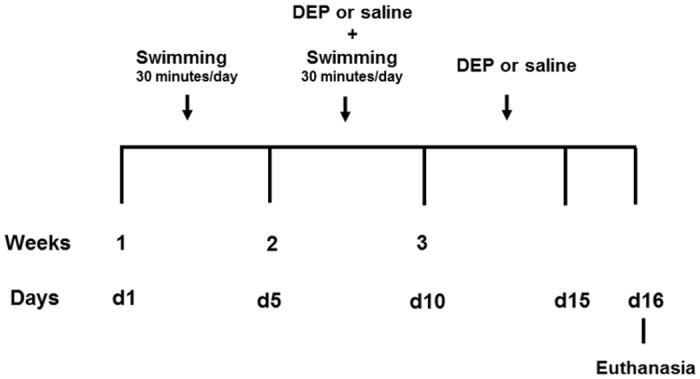
Time line of the experimental protocol.Swimming was initiated on day 1, and ended on the 10th experiment day. DEP instillation occurred from 5th to 10th day of the swimming protocol, and until the 15th day, the animals were submitted only to daily DEP or saline instillation. Animals were euthanized 24 hours after the last instillation.